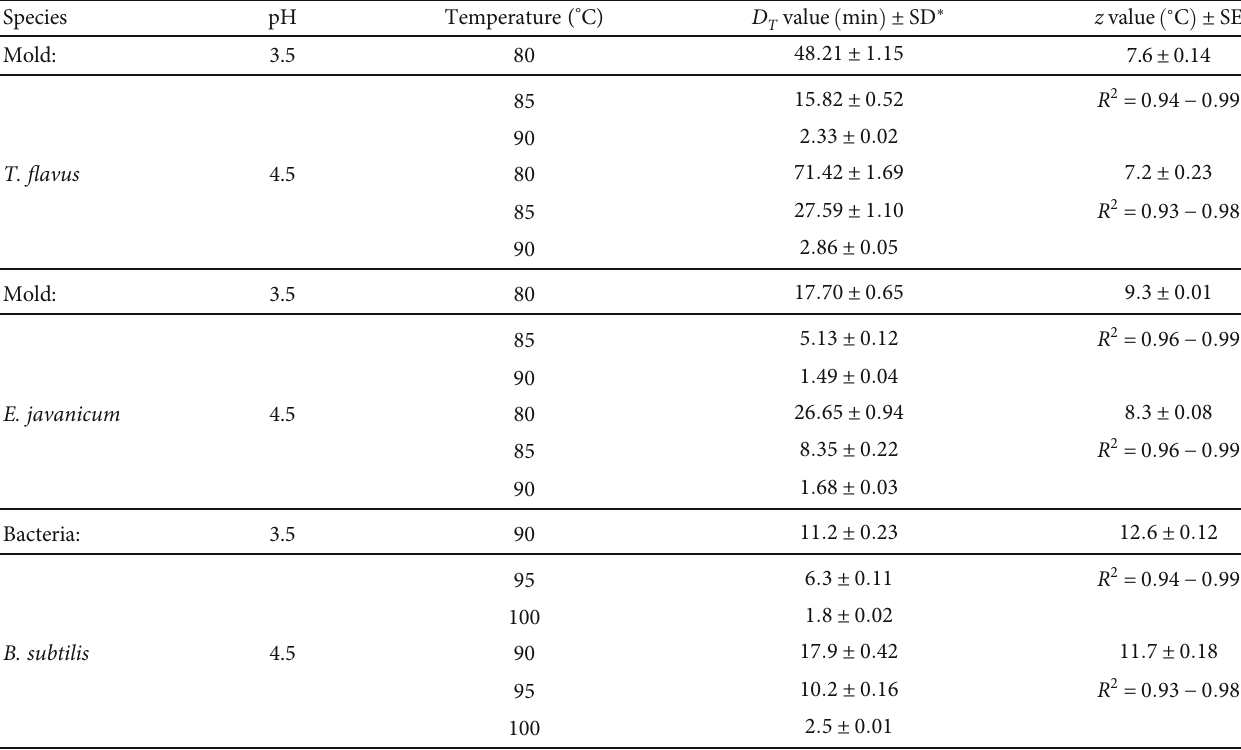
∗ D values shown are average of twoexperiments ± standarddeviation the D values obtained being 15 : 33 ± 1 : 7 min, 8 : 25 ± 0 : 9 min,